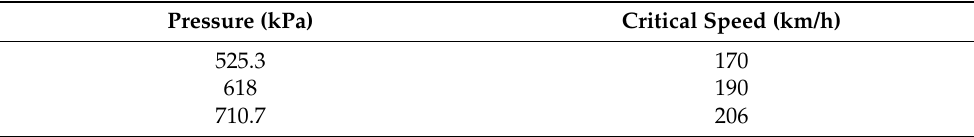
Table 5. Standing wave simulation results based on inflation pressure change. Table 6. Standing wave simulation results based on vertical load change. Pressure (kPa)